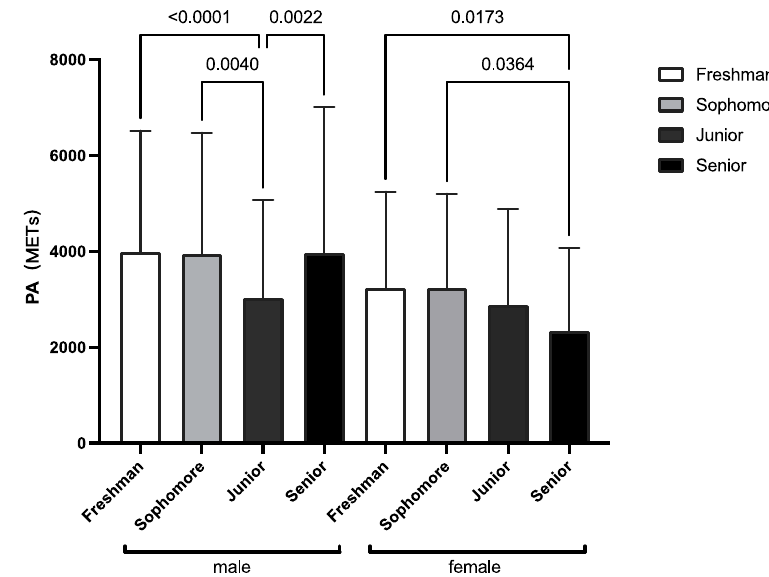
Figure 3. The PA (METs) in different academic years in males and females.